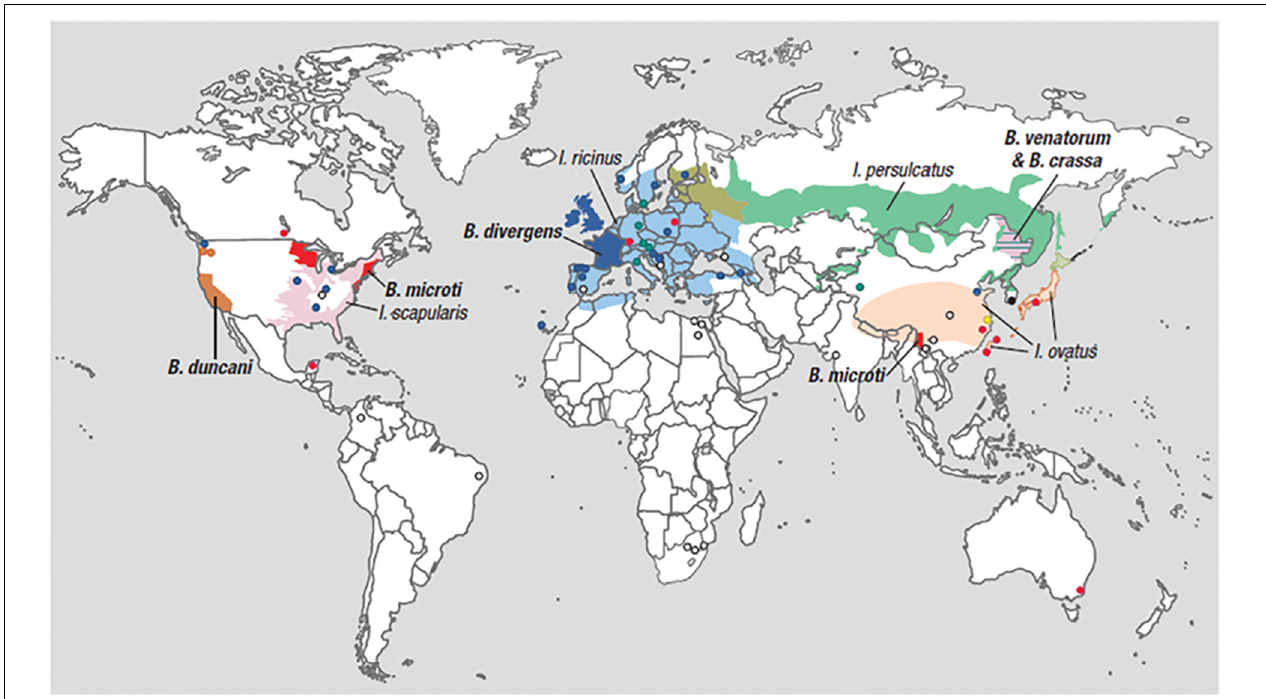
FIGURE 1 | Geographic range of Ixodes -tick vectors and location of human babesiosis reports. The lighter colors represent the geographical range of several Ixodes tick species known or suspected to transmit Babesia parasites to humans but where human babesiosis is rare ( < 5 cases), unreported or absent. Ixodes ricinus and Ixodes persulcatus are sympatric in southern Finland, Estonia, Latvia, and northwestern Russia, while I. persulcatus and Ixodes ovatus are both enzootic in Hokkaido in northern Japan. The darker colors represent regions where human babesiosis is endemic or sporadic (defined by ≥ 5 cases). Circles indicate single cases, except in three locations (Mexico, Montenegro, and eastern Poland) where all patients at these locations were reported from the same hospital. Colors indicate Babesia species: red for B. microti , orange for B. duncani , blue for B. divergens , green for B. venatorum , pink for B. crassa like agent, black for KO-1, yellow for Babesia spp. XXB/HangZhou, and white for undetermined Babesia spp. The map does not show asymptomatic cases and travel-associated cases [adapted from Vannier and Krause (2012) and (Ryan et al., 2019) from The New England Journal of Medicine, Edouard Vannier, PhD., and Peter J. Krause, M. D., Human Babesiosis, 366, 2399. Copyright (2012) Massachusetts Medical Society. Reprinted with